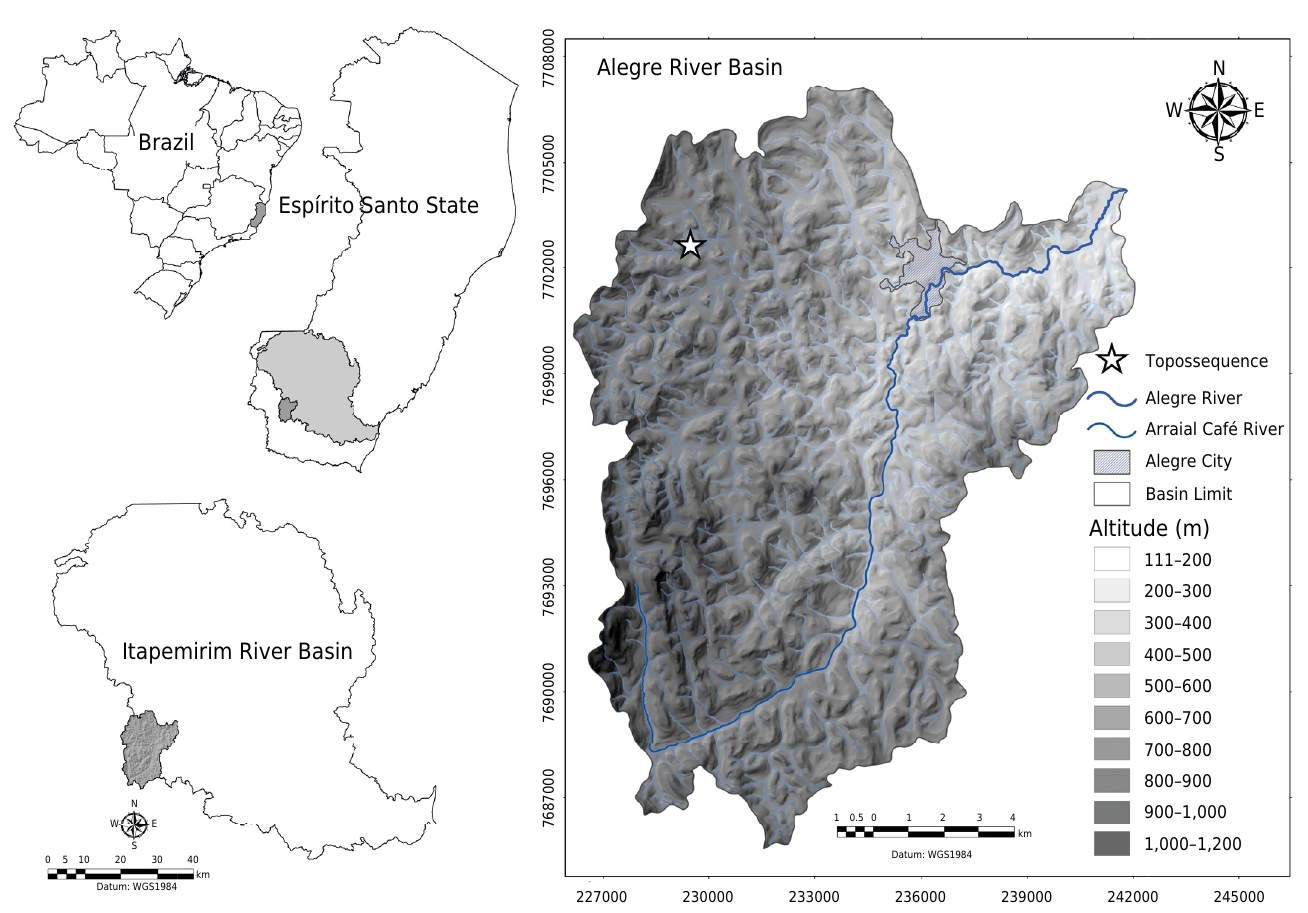
Figure 1. Location of the Alegre river basin, Espírito Santo State,